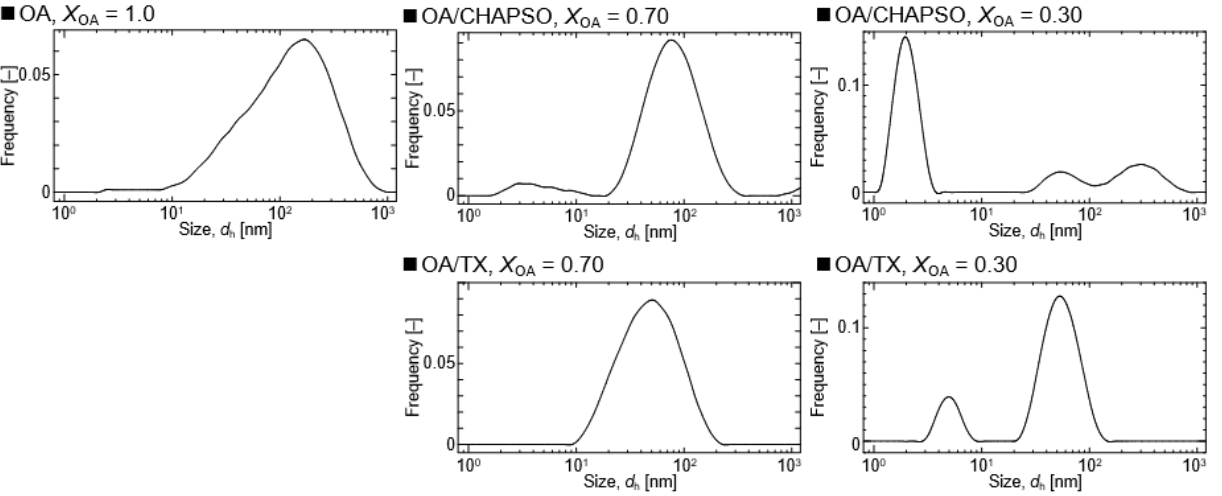
Figure 2. Size distributions of OA/detergent (CHAPSO or TX) bicelles at 20 mM and at 298 K.